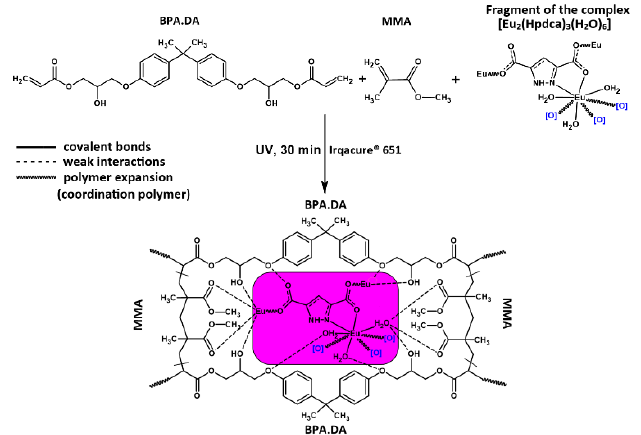
Figure 1. Scheme of the hybrid materials’ synthesis and proposed structure of obtained materials based on the europim(III) complex.